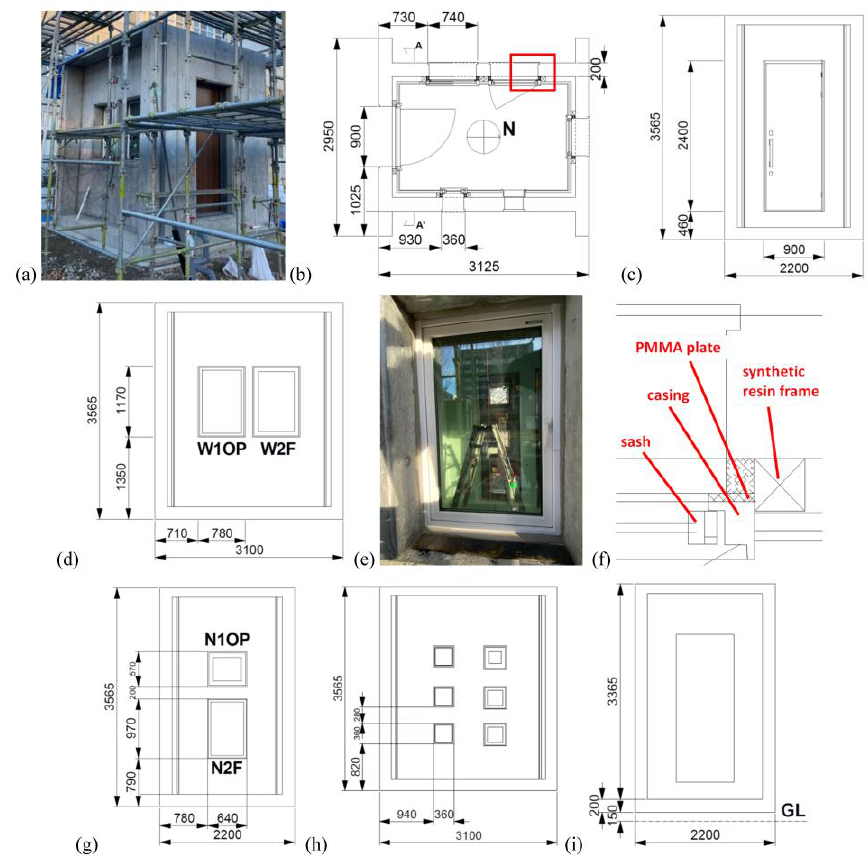
Figure 2. Tested specimen (unit: mm): ( a ) the specimen, ( b ) plan, ( c ) south elevation, ( d ) west elevation, ( e ) operable window in the west elevation, ( f ) its cross section, ( g ) north elevation, ( h ) east elevation and ( i ) AA’ cross section.